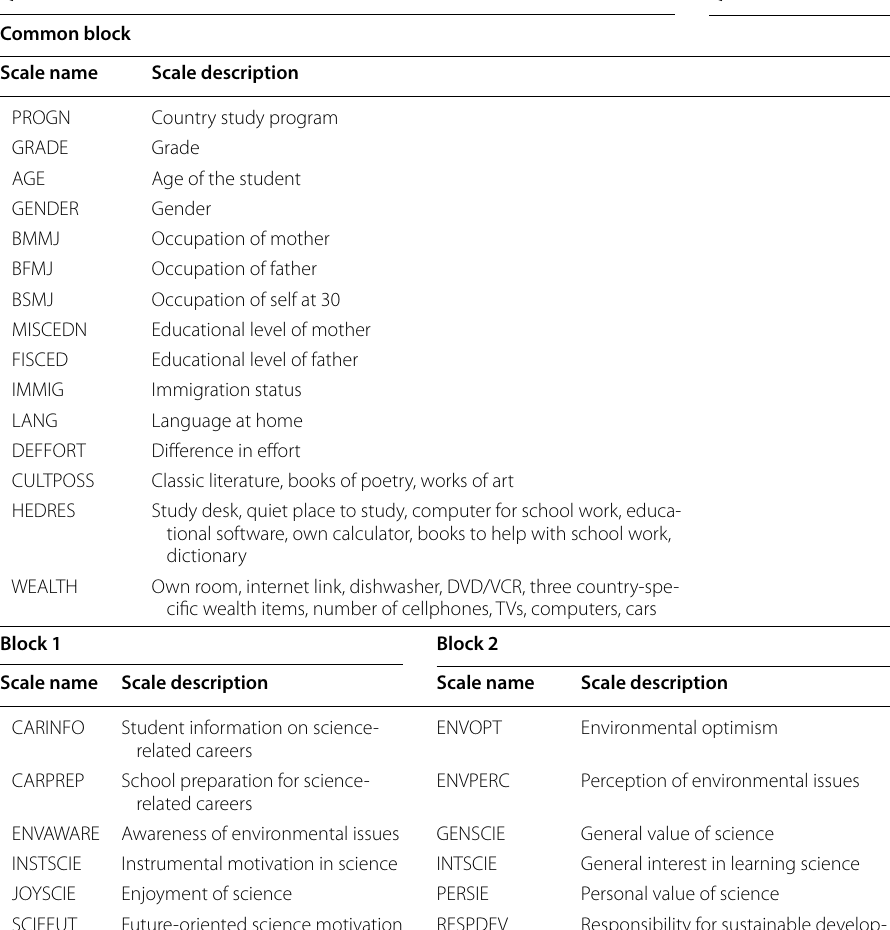
Table 1 Two-form design for PISA 2006 simulation study based on Adams et al. (2013) Questionnaire form